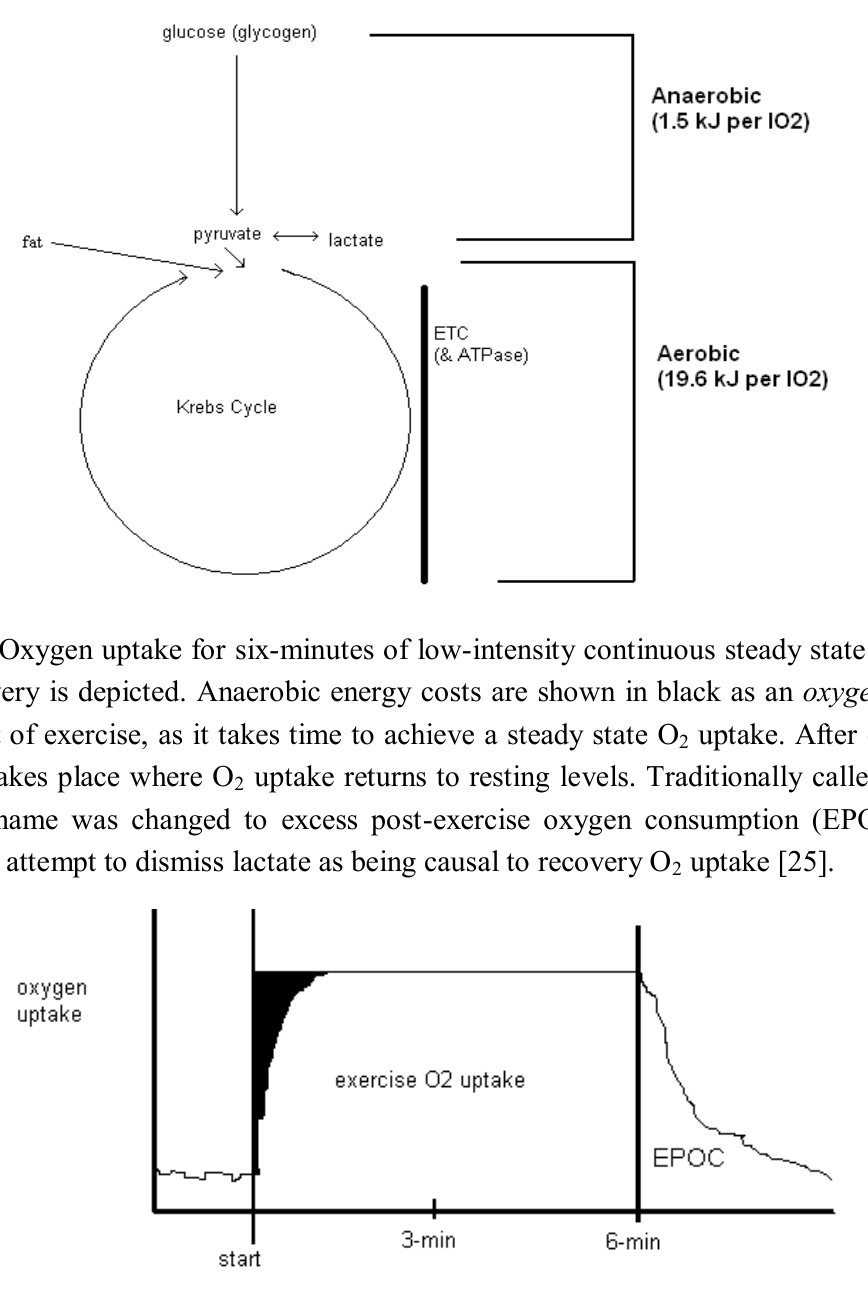
Figure 1. The complete metabolic degradation (biological oxidation) of glucose is converted to an estimate of energy expenditure as 21.1 kJ per liter of measured O uptake. 2 In this example, the origins of that energy expenditure are hypothesized to have an anaerobic (glycolytic) component at 1.5 kJ per liter of O uptake and, an aerobic 2 component at 19.6 kJ per liter of O uptake. Via aerobic respiratory-only metabolism, fat 2 and lactate oxidation have no anaerobic component at 19.6 kJ per liter of O uptake. 2 ETC = electron transport chain. ATPase = mitochondrial ATPase.